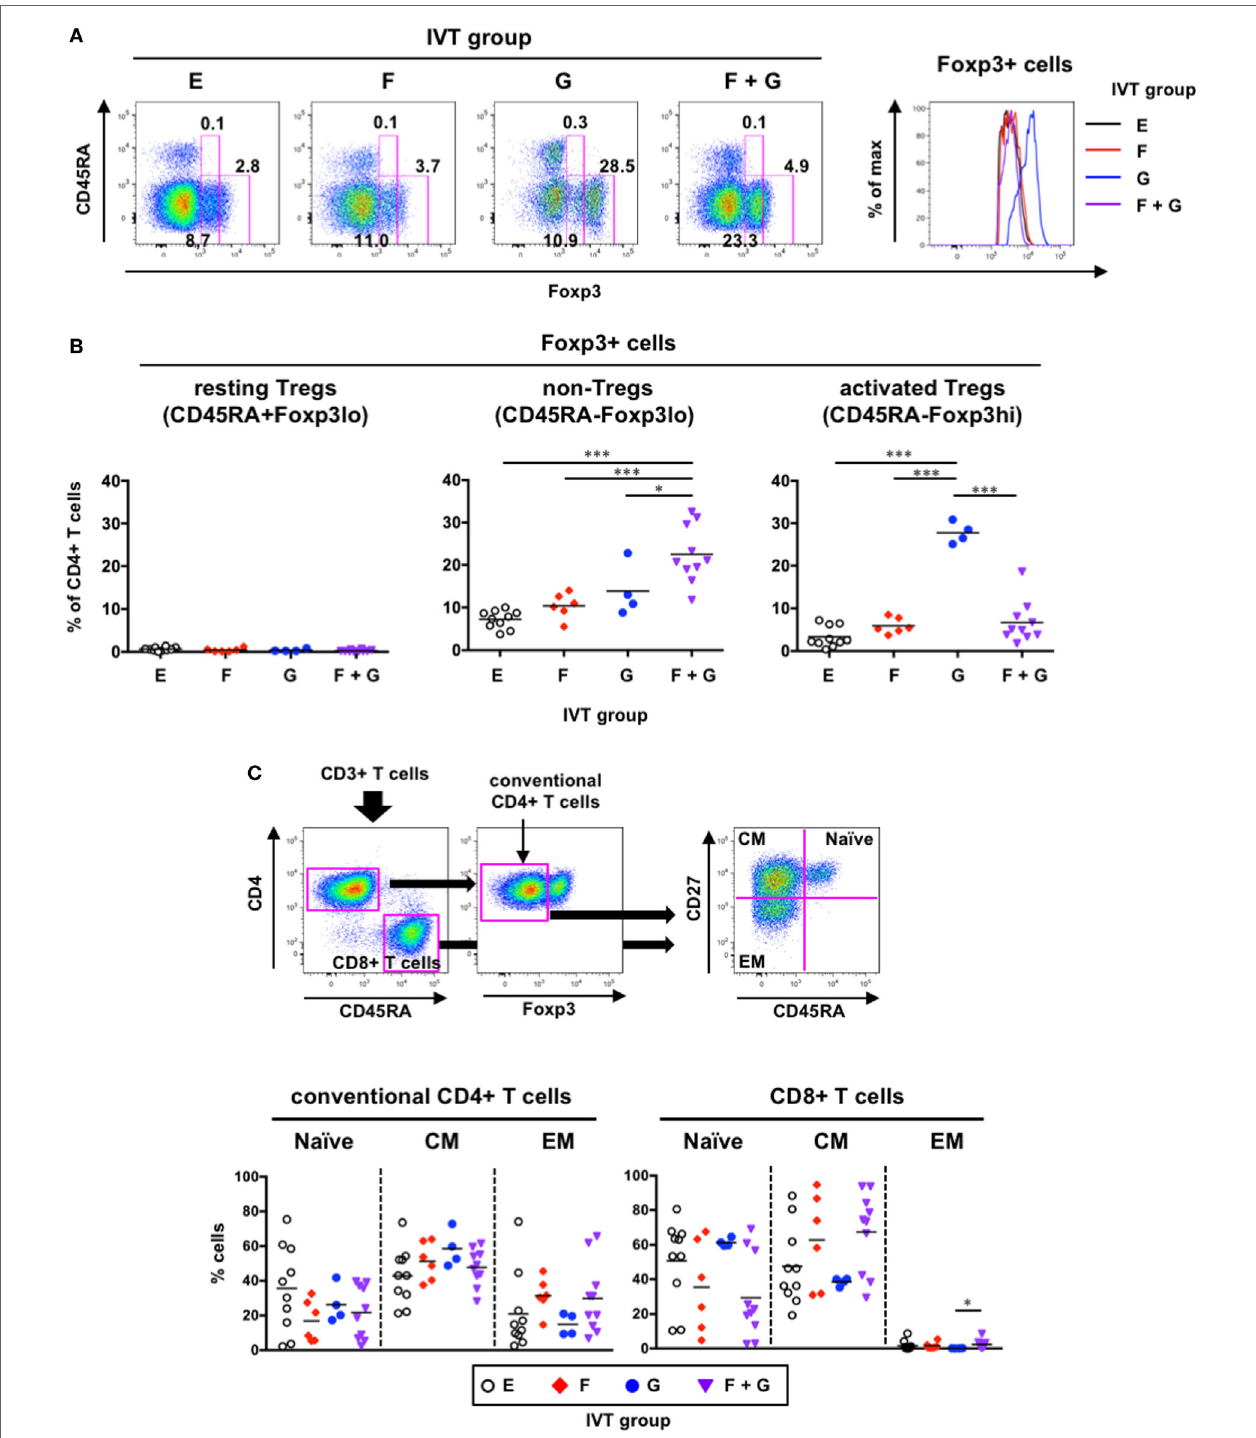
FigUre 8 | Phenotypic analysis of human T cells in hNOJ mice following in vivo transfection (IVT). Splenocytes from each IVT group were subjected to flow cytometric analysis for T cell phenotyping. (a) A representative gating strategy for resting regulatory T cells (Tregs) (CD45RA + Foxp3 lo ), non-Tregs (CD45RA − Foxp3 lo ), and activated Tregs (CD45RA − Foxp3 hi ) within Foxp3 + CD4 + T cells. The histogram shows higher expression of Foxp3 in Group G. (b) Comparison of the percentages of Foxp3 + CD4 + T cell subsets among the IVT groups. Significant differences (* P < 0.05, *** P < 0.001) were determined by one-way ANOVA followed by the Holm– Sidak’s multiple comparisons test (Group E: n = 10, Group F: n = 6, Group G: n = 4, Group F + G: n = 10). (c) A representative gating strategy for conventional CD4 + T cells and CD8 + T cells and differentiation stages of each T cell population. Significant difference (* P < 0.05) was determined by the Kruskal–Wallis test followed by the Dunn’s multiple comparisons test (Group E: n = 10, Group F: n = 6, Group G: n = 4, Group F + G: n = 10).